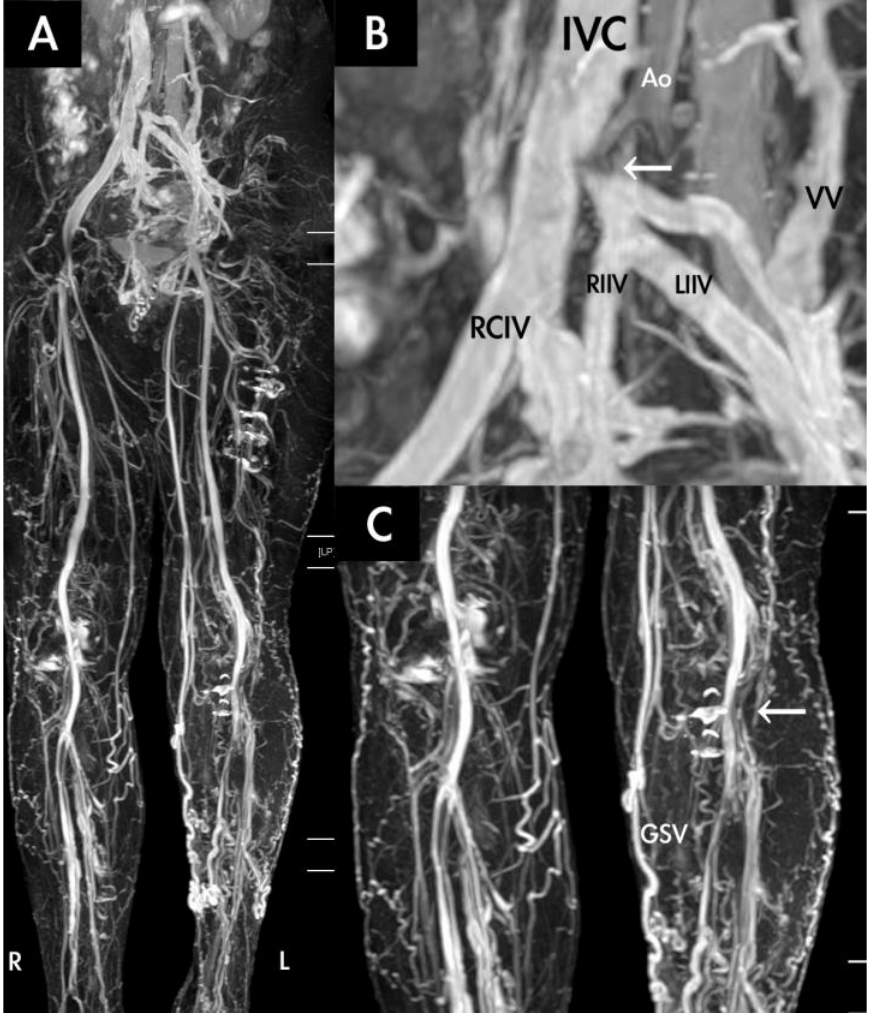
Figure 3. A 60-year-old woman who received TRANCE-MRI for her painful left varicose vein with 50 m claudication. ( A ) Her greater saphenous vein in left leg was obviously more engorged than that in the right leg. ( B ) Normal inferior vena cava (IVC) and right common iliac vein. Her right internal iliac vein and left internal iliac vein drain into the left common iliac vein (white arrow), which is compressed by the aorta (Ao). Prominent collateral veins (VV) draining into the renal vein can be clearly observed. RCIV: right common iliac vein; RIIV: right internal iliac vein; LIIV: left internal iliac vein ( C ) A diseased left popliteal vein (white arrow) and varicose left greater saphenous vein (GSV) can be